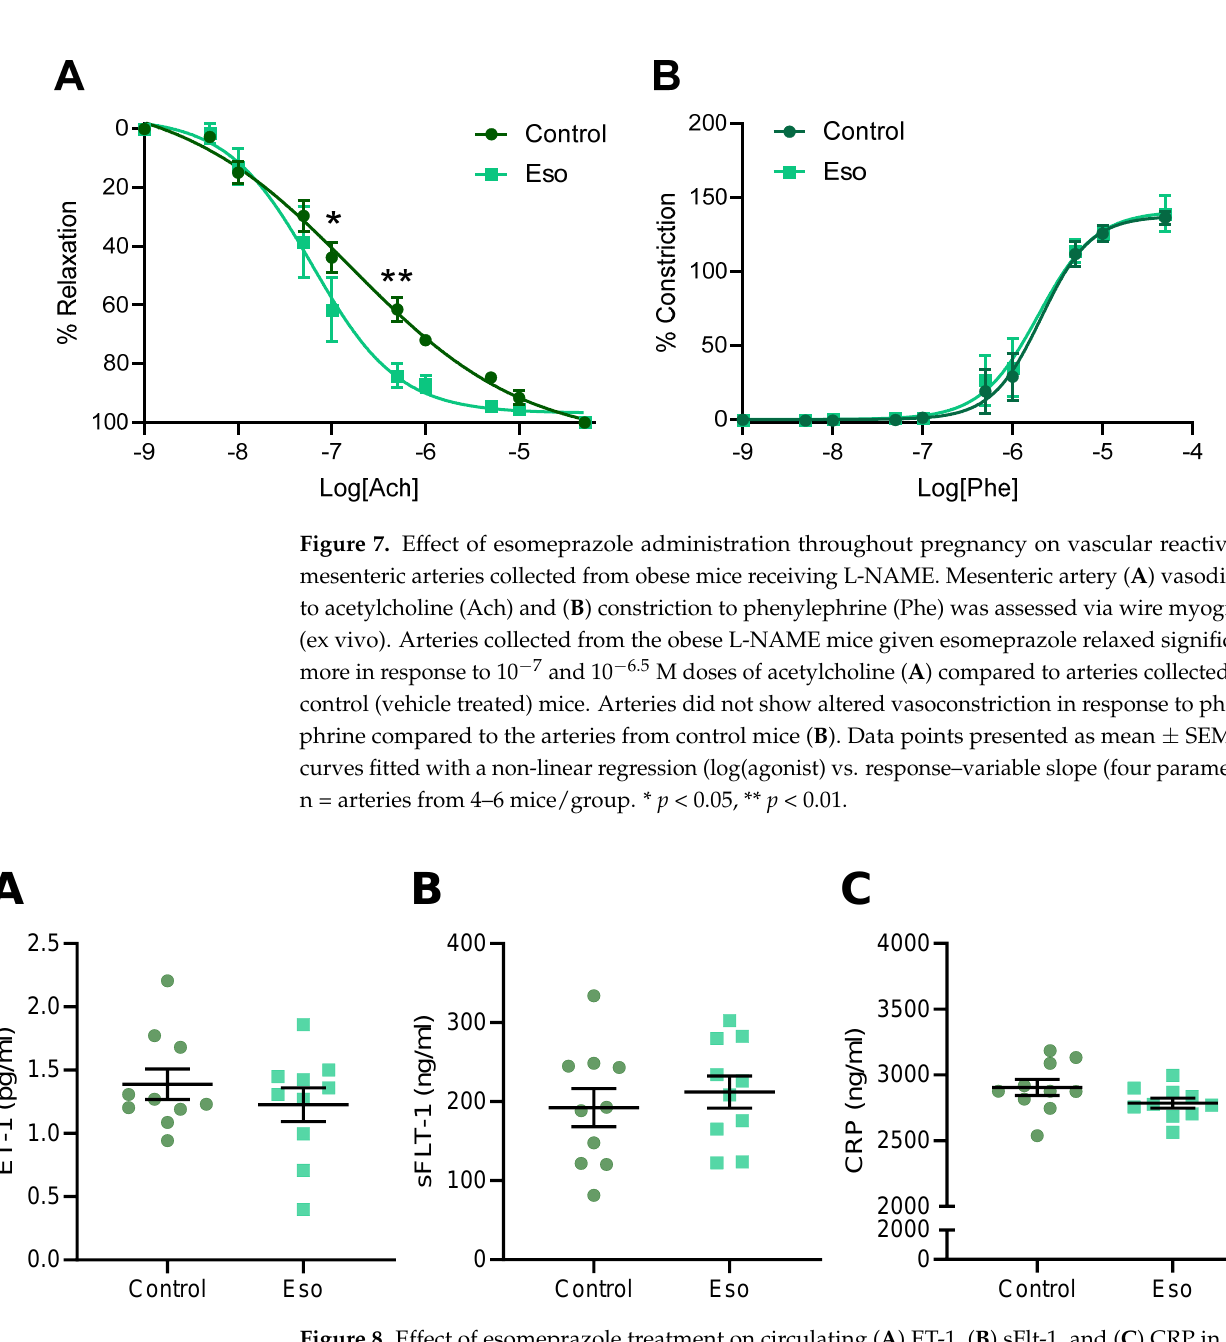
Figure 8. Effect of esomeprazole treatment on circulating ( A ) ET-1, ( B ) sFlt-1, and ( C ) CRP in obese L-NAME mice. Serum levels of these factors were assessed via ELISA. Obese mice receiving L- NAME treated with esomeprazole did not have altered circulating ( A ) ET-1, ( B ) sFlt-1, or ( C ) CRP compared to the controls. Data presented as mean ± SEM; n = 10 mice/group.